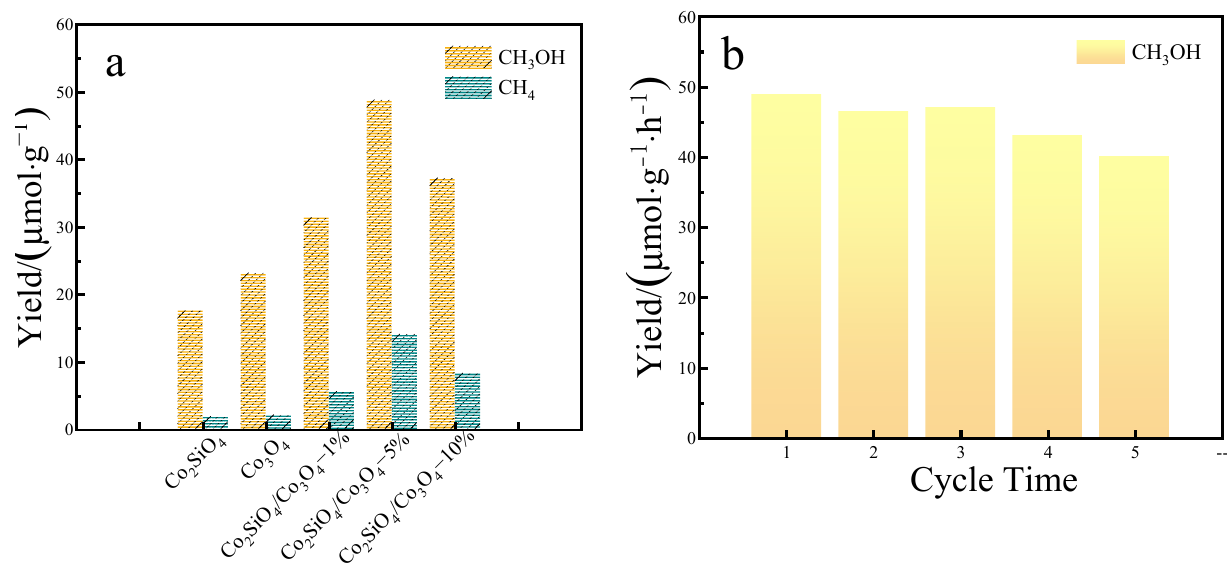
Figure 7. ( a ) CO 2 reduction performance of Co 3 O 4 , Co 2 SiO 4 , and Co 2 SiO 4 /Co 3 O 4 − x under solar light; ( b ) stability of Co 2 SiO 4 /Co 3 O 4 − x photothermal CO 2 reduction.